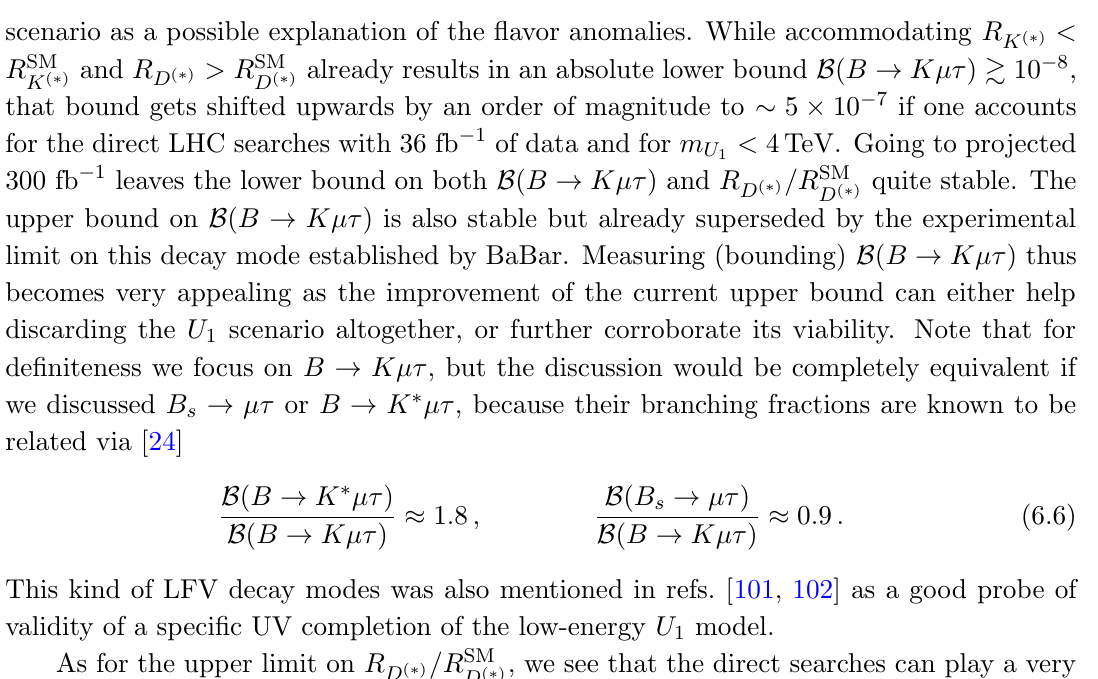
Figure 10 . m U is plotted against B ( B ! K(cid:22)(cid:28) ) (left panel) and R 1 U 1 model. Color code is the same as in (cid:12)gure